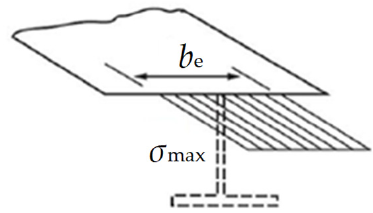
Figure 2. Notion of the effective width, b e , of the attached plating in stiffener bending. This figure shows a representative section of a stiffened plate with “Tee” profile stiffeners that have a specific spacing, s . The shear lag effect reduces the actual width and a corresponding static equivalent stress, σ max, is assumed.